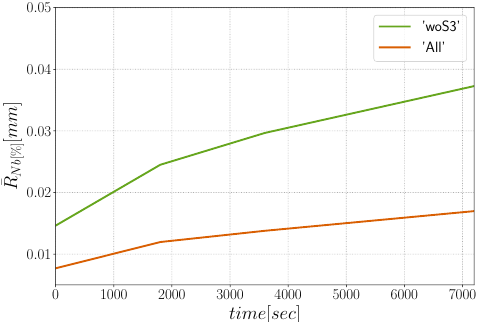
Figure 6. Mean grain radius evolution at 1050 ◦ C from experimental data measured in 2D sections by taking into account all boundaries (in orange) and without TBs (in green). The outer grains that share a boundary with the image borders are not taken into account in the analysis.